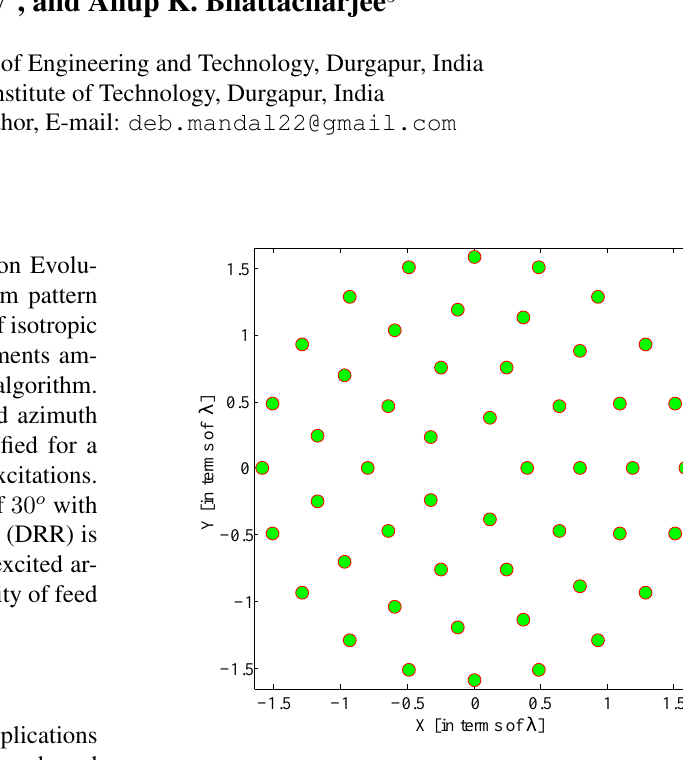
have been carried out using Differential Evolution Al- gorithm, which improves the dynamic range ratio by elimi- nating weekly excited array elements